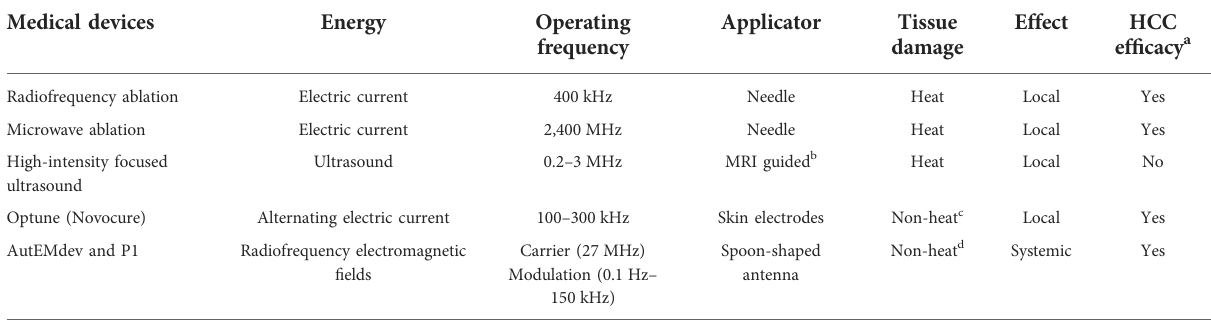
TABLE 1 Wave-therapy devices for oncology. Medical